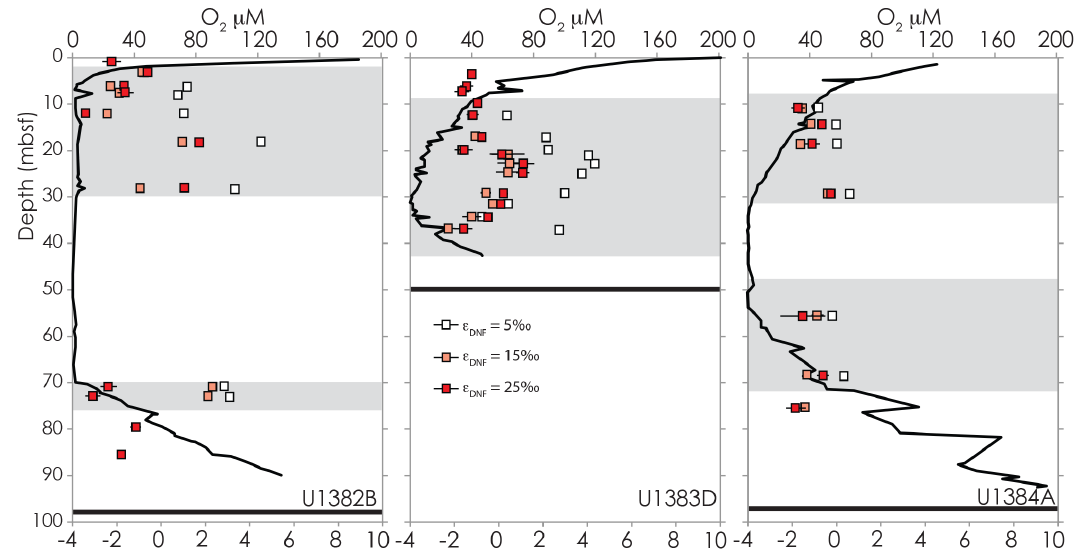
Figure 5. Model-estimated values for the N isotopic composition of new nitrate produced by nitrification ( δ 15 N NTR ) occurring within porewaters. Values are calculated for depths at which O 2 concentrations were >2µM (e.g., oxic and transitional intervals). Sensitivity of δ 15 N NTR to prescribed values of the isotope effect for denitrification ( 15 ε DNF ) in transitional intervals, where both nitrification and denitrification can co-occur, is also indicated.